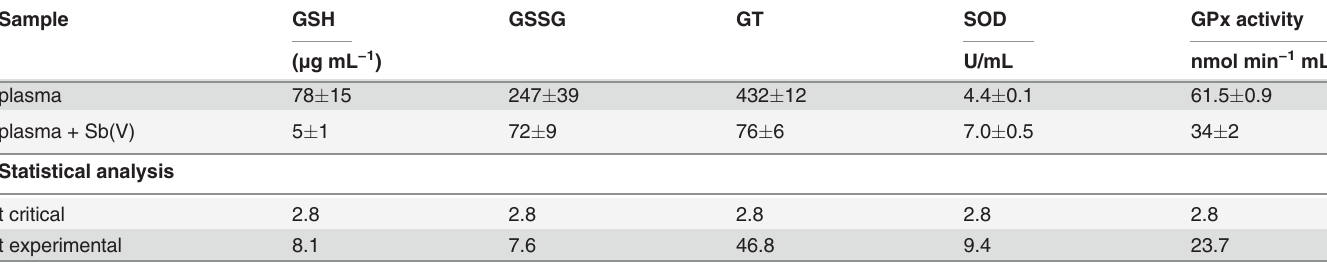
Table 3. The effect of Sb(V) on GSH, GSSG, GT, SOD and GPx levels in human plasma.